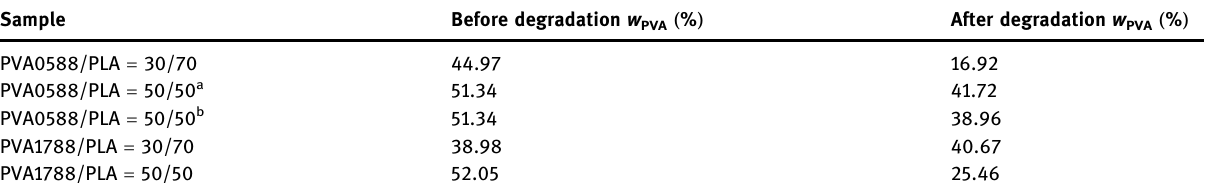
Table 5: Changes in the relative mass fractions of PVA in the blends before and after degradation in natural seawater Sample Before degradation w PVA ( %